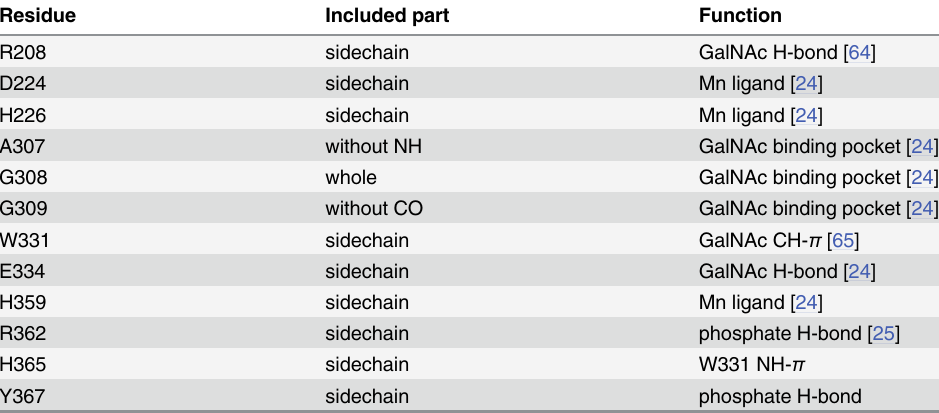
Table 2. Parts of conserved enzyme residues included in QM